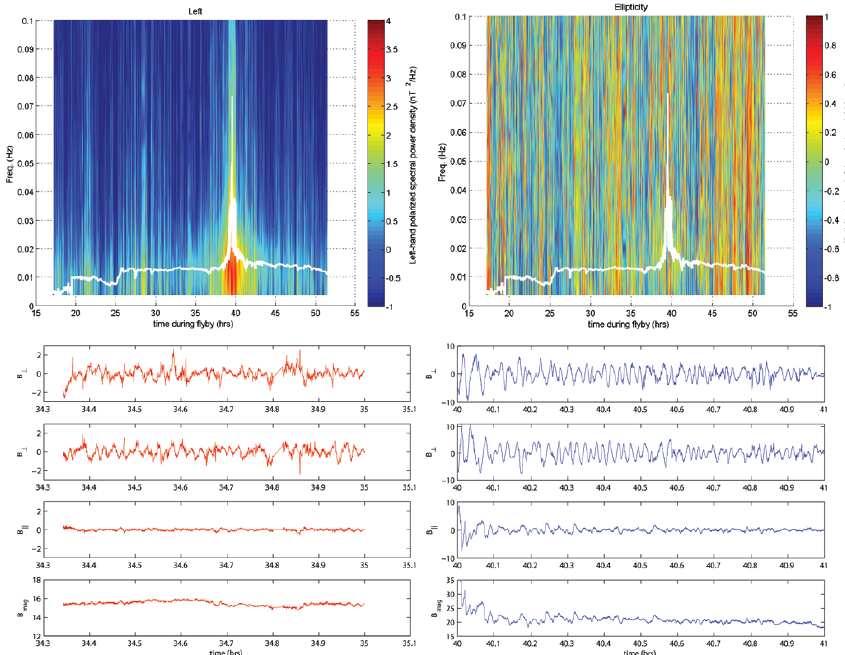
Fig. 4. Top left: the dynamic spectrum of the left-hand polarized magnetic field data from the Giotto magnetometer for the GS flyby from hour 15 to hour 56, where hour 0 is taken at 9 July 1992, DOY 191, at 00:00UT. Closest approach was at hour 39.25. The white overlay line marks the H 2 O + cyclotron frequency. Top right: the dynamic ellipticity for the frequency estimates of the power spectrum in the left panel. Positive ellipticity for right-hand polarized, negative ellipticity for left-hand polarized waves. Bottom left: Giotto magnetometer data for hour 34–35 of the flyby, before closest approach, in MFA coordinates. The weak waves, at the water cyclotron frequency, are erratic and not well developed. Bottom right: Giotto magnetometer data for hour 40–41 of the flyby, after closest approach. The strong waves, at the water cyclotron frequency, are “anharmonic” but well